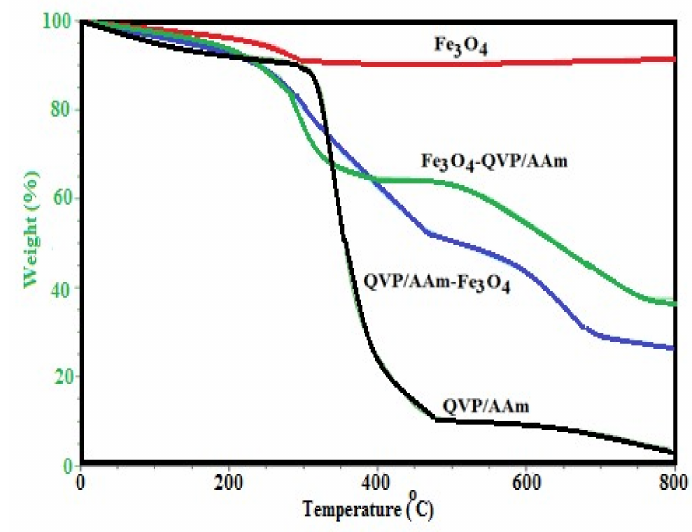
Figure 6. TGA thermograms of QVP / AAm